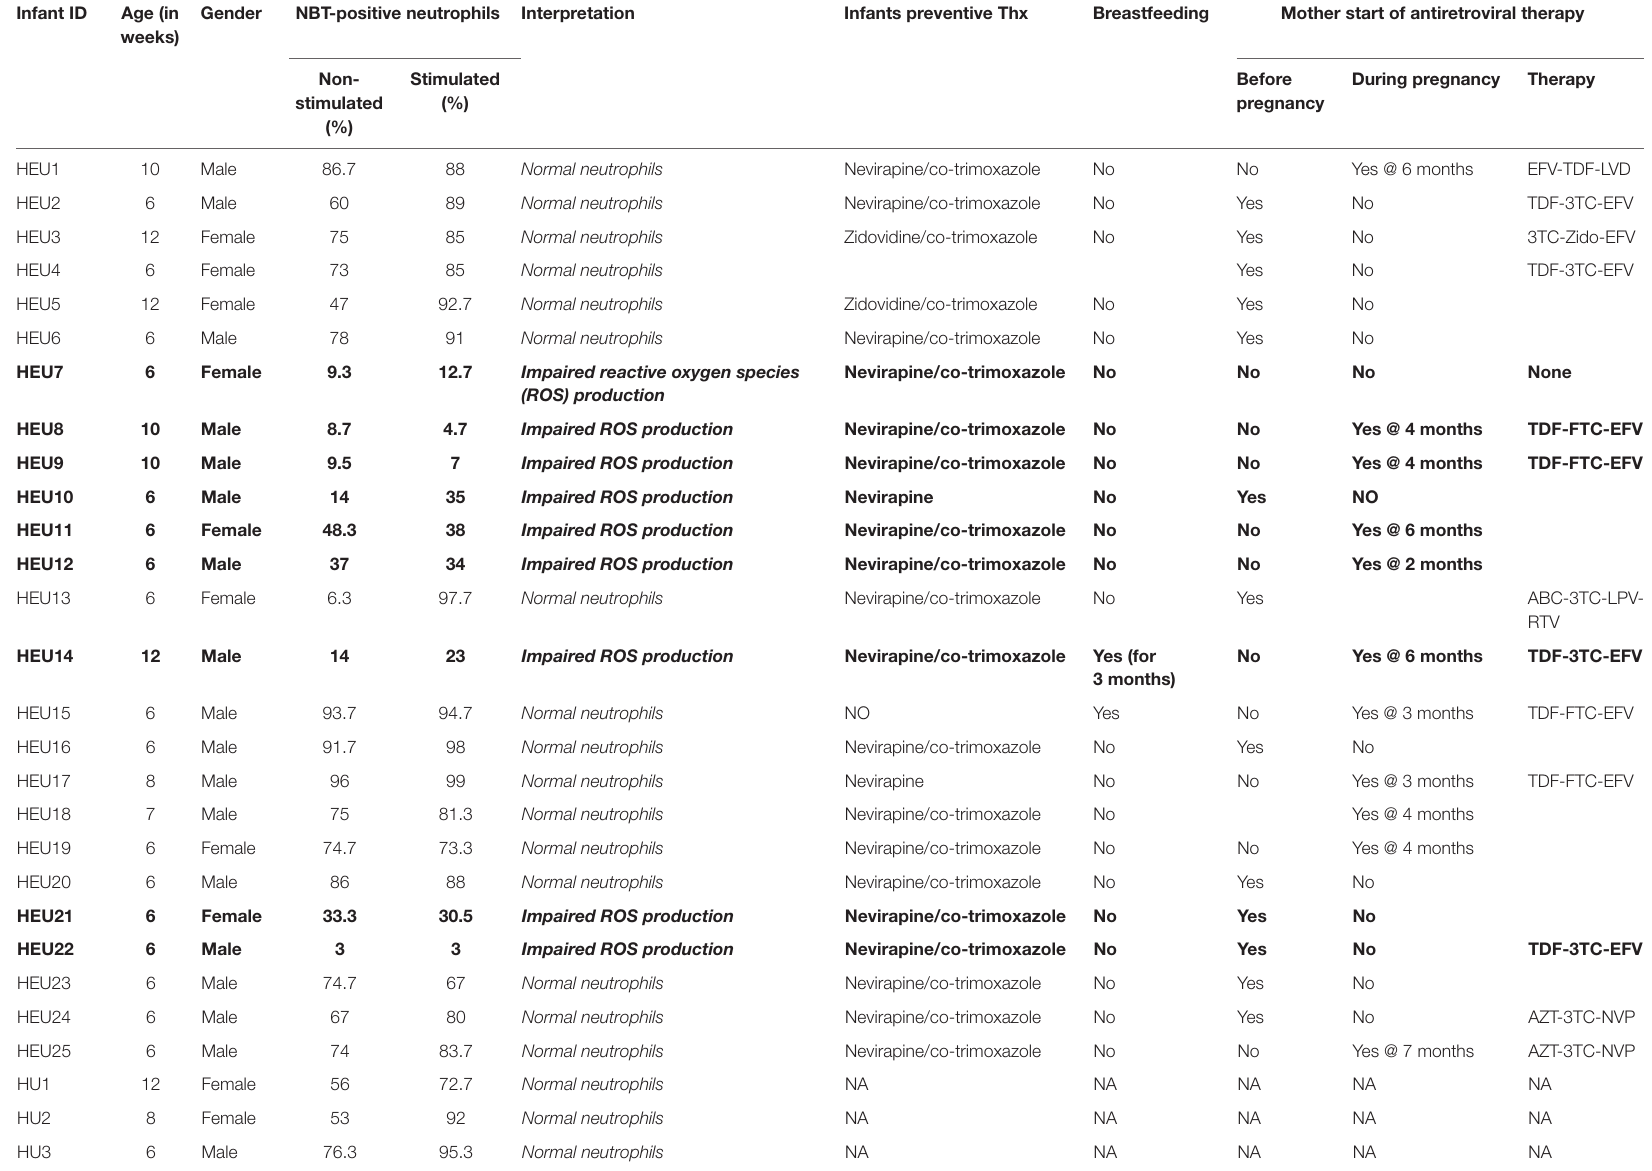
Bold font indicates Impaired ROS